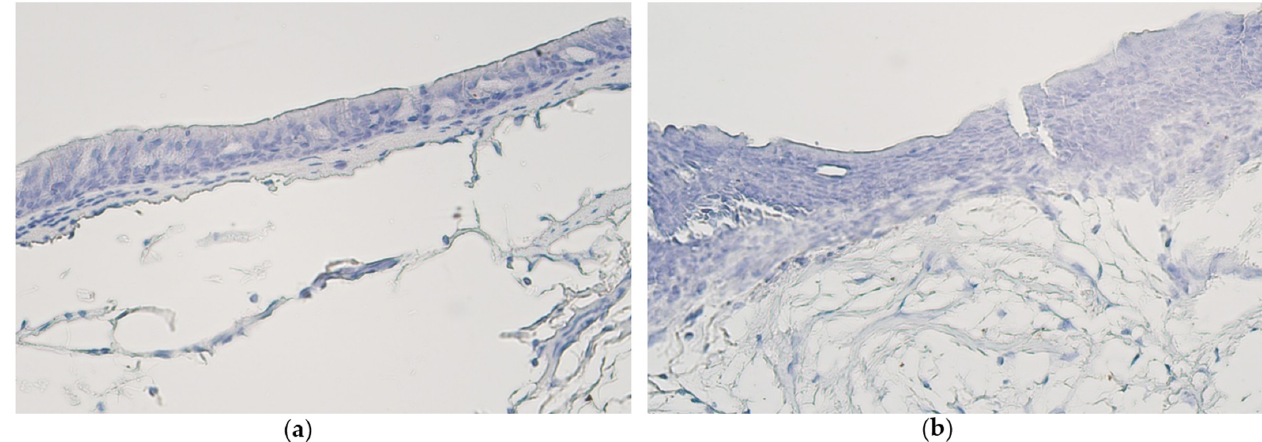
Figure 2. ( a ) No Ki-67-positive cells are found in non-changed bronchial epithelium of a 64-year-old male. Ki-67 IMH, X200. ( b ) All bronchial epithelium cells are Ki-67 negative in a metaplastic tissue material of a 61-year-old male. Ki-67 IMH, X200.